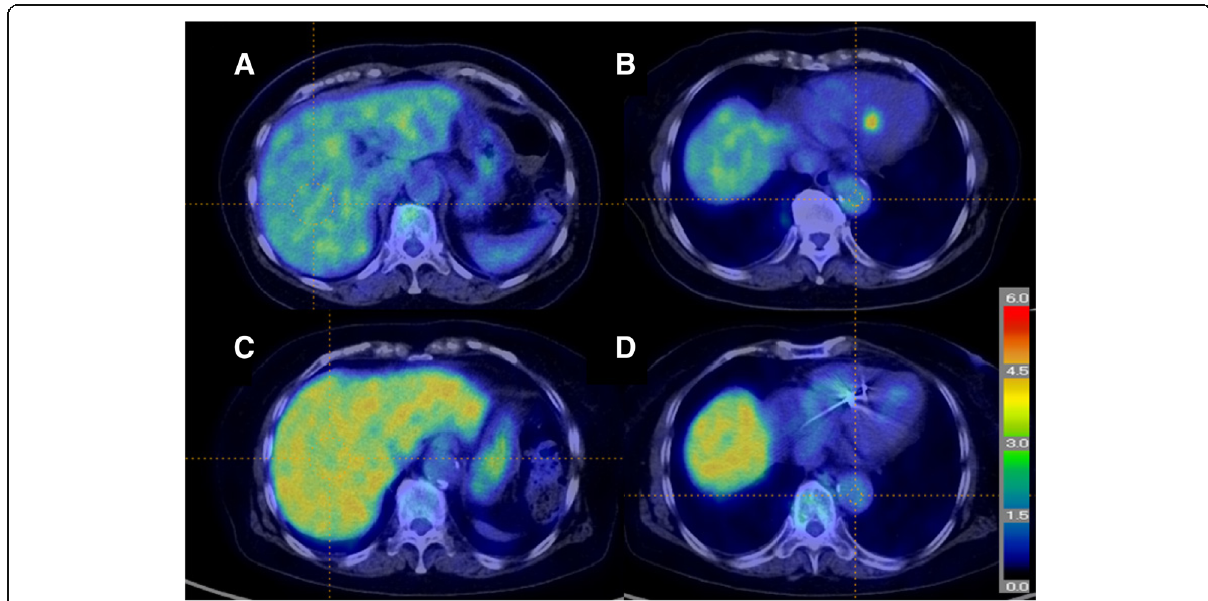
Fig. 1 A representative case before and during the oral steroid therapy of CS. 18 F-FDG PET/CT images obtained before ( a , b ) and during ( c , d ) treatment of CS. Note the profound decline in the myocardial uptake and increase in the liver uptake. The threshold increased from the time point before ( a , 3.7) to that during steroid therapy ( c , 4.5). The SUV of the DA showed little change from the time point before ( b , SUVmax 2.9;